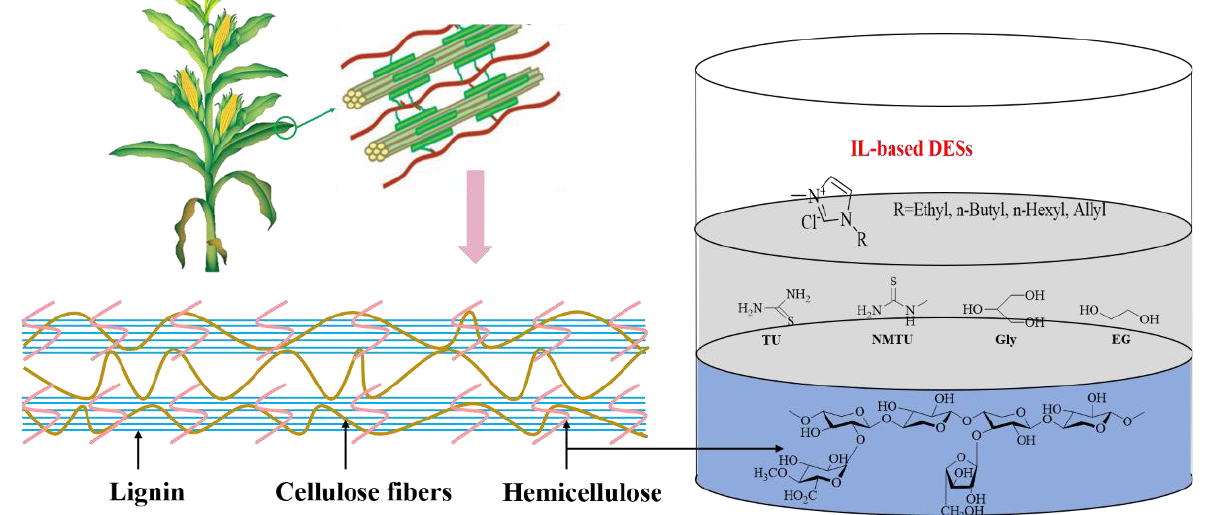
Figure 1. IL-based DESs were developed for highly efficient dissolution of xylan.